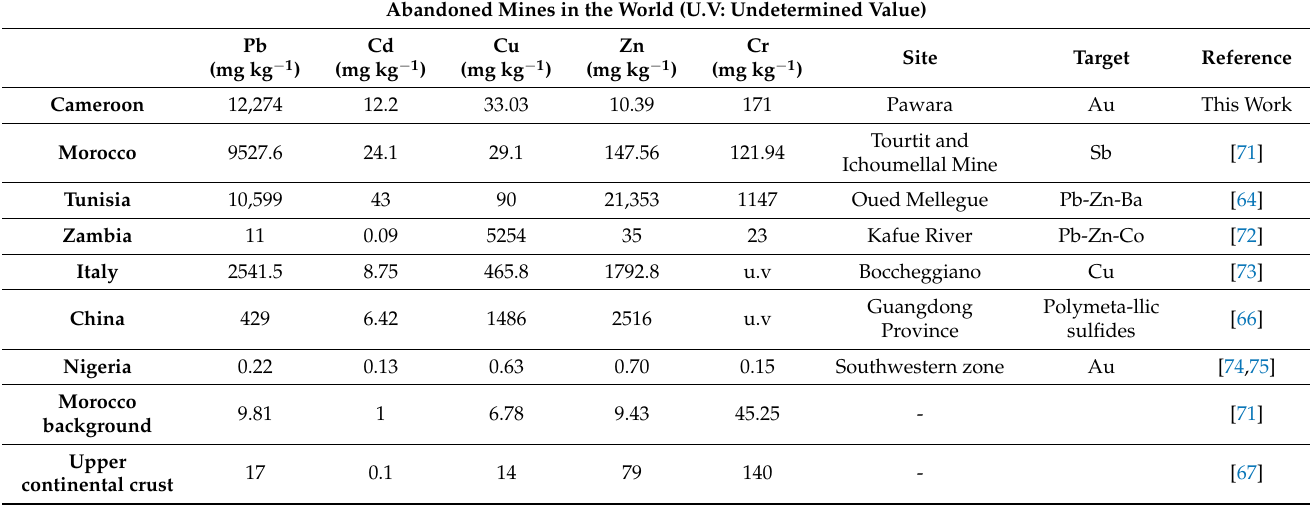
Table 5. Comparative table of mean concentrations of metallic trace elements in mining wastes in the study area with the abandoned mines worldwide [67].